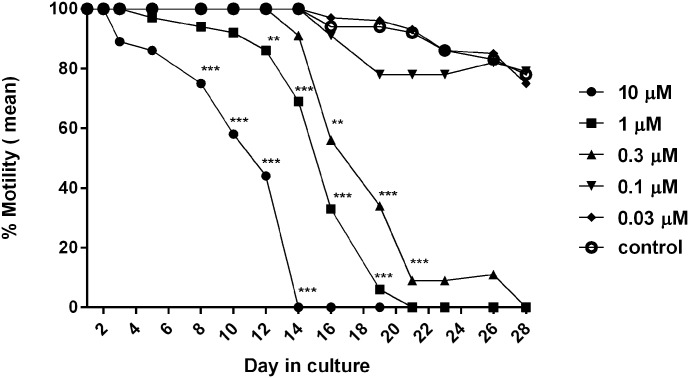
Motility of O. volvulus L5 worms exposed to different concentrations of flubendazole.Treatment was for 14 days with an additional 14 day follow up without the drug. Flubendazole (0.3 μM and higher) caused significant inhibition of worms’ motility. Specifically: 10 μM of the drug caused significant (***—p<0.001, n = 9) inhibition of motility as compared with control (n = 14) starting on the 9th day; 1 μM of the drug caused significant (**—p<0.01, n = 11) inhibition of motility as compared with control (n = 14) starting on the 12th day; and 0.3 μM of drug caused significant (p<0.01, n = 8) inhibition of motility as compared with control (n = 14) starting on the 16th day. Motility was observed using a microscope and scored based on the following scale: 100% motility, constant coiling movement; 75% motility, slower coiling; 50% motility, slow and intermittent movement; 25% motility, very slow movement or twitching; and 0% motility, no movement.